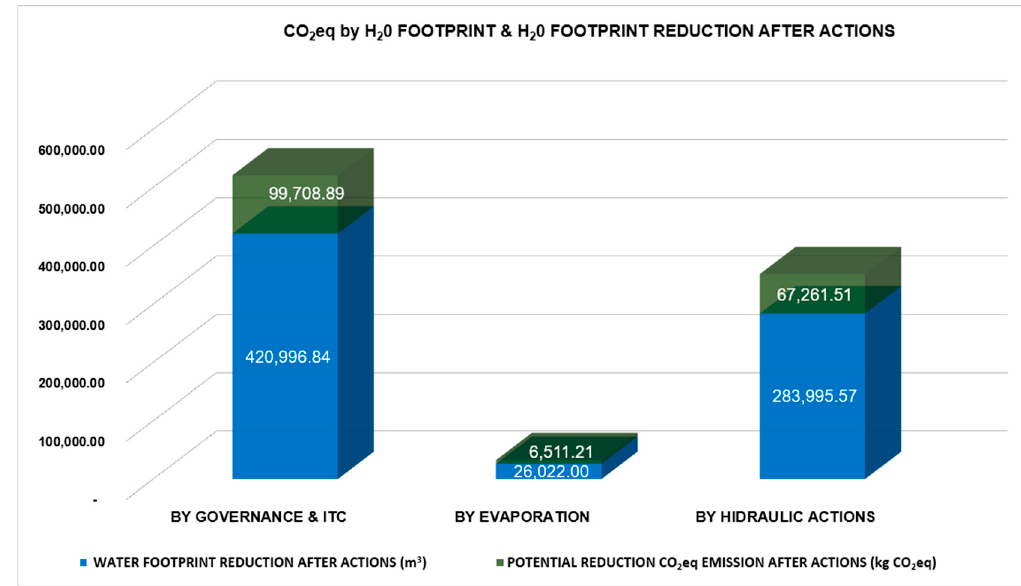
Figure 10. CO 2 eq reduction by water footprint after actions. Source: Own elaboration.